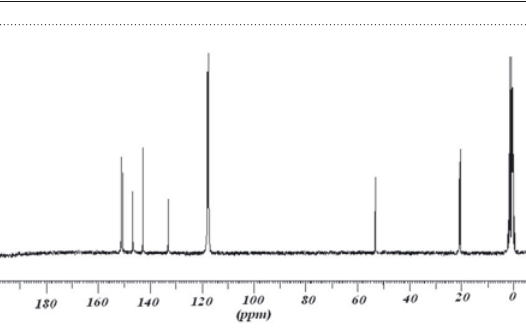
Figure 3. 13 C NMR spectrum of compound 2